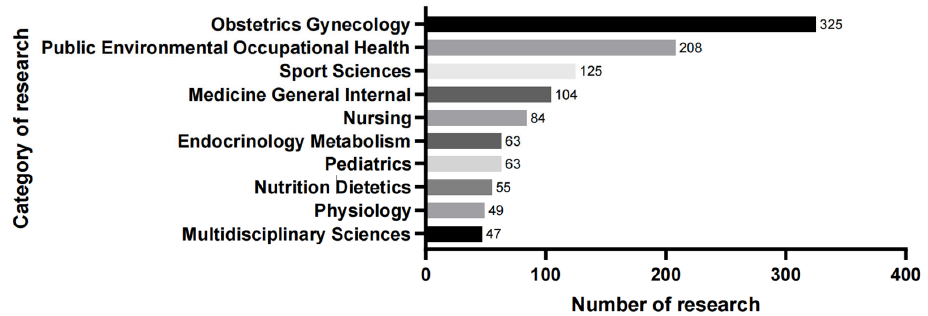
Figure 3. Distribution of categories in research of physical activity during pregnancy.